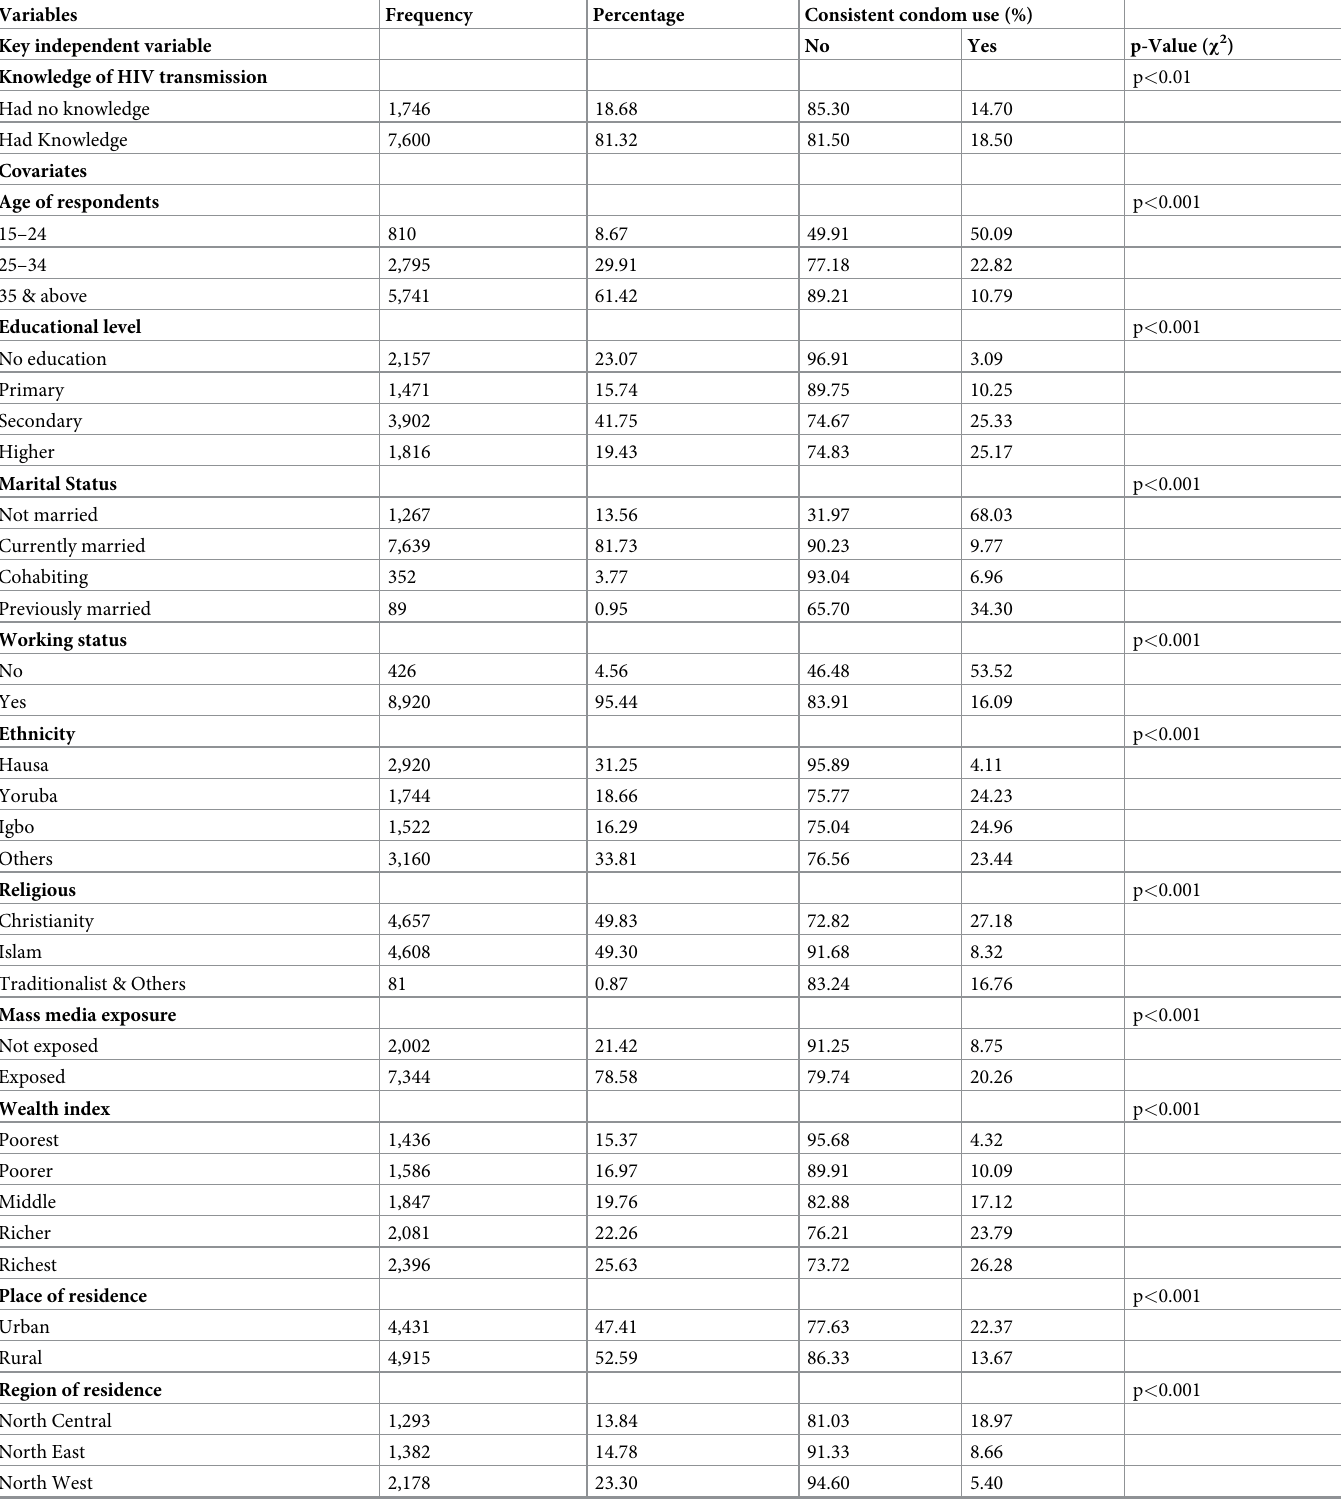
Table 1. Weighted distribution and chi-square analysis of sexually active men by consistent condom use in Nigeria (N =